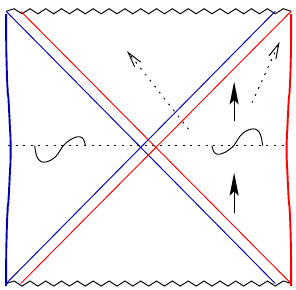
Figure 6 . We illustrate here the bulk perturbative dynamics. The initial condition is given at (cid:23) = 0. The left and the right initial perturbations can be independent from each other. The dotted lines with an arrow represent possible bulk observer’s trajectories. All the information they can gather lies in the right side of horizons that are colored in